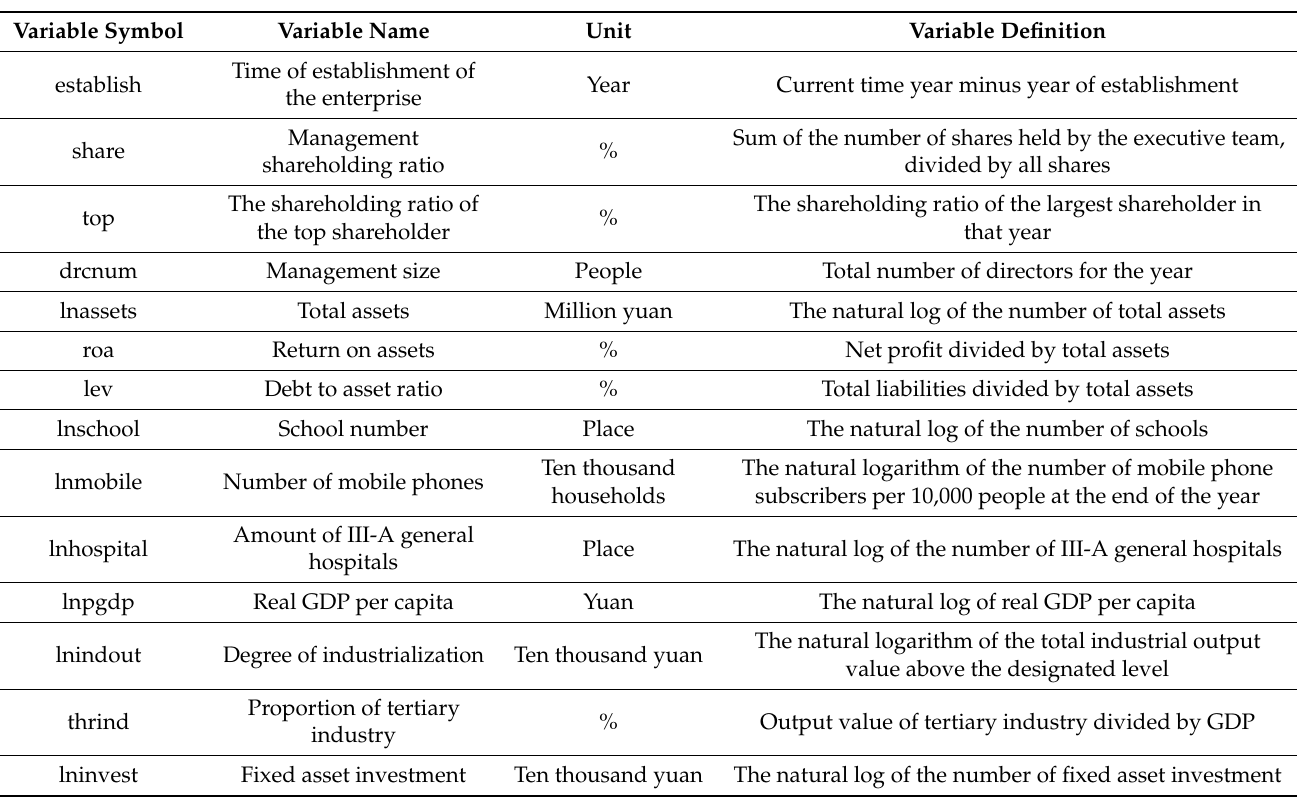
Table 3. Variable